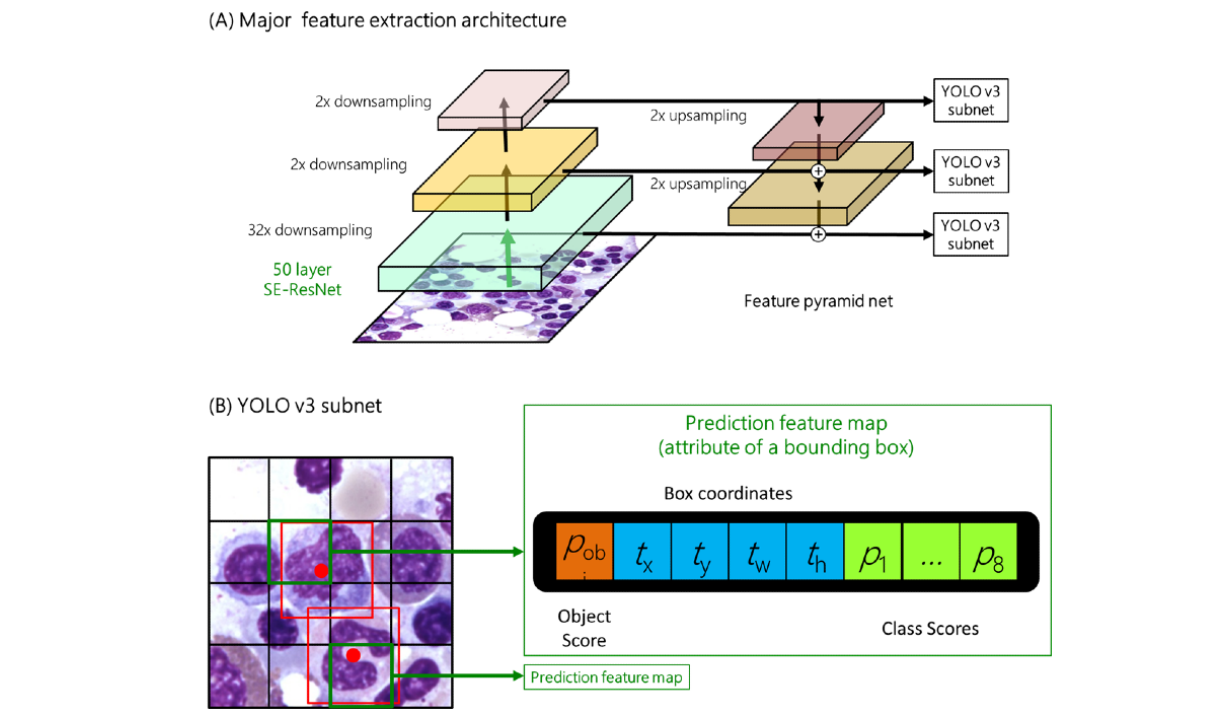
Figure 1. Deep learning model architecture. Our model contains a feature extraction architecture and a bounding box prediction subnet. The feature extraction architecture is based on a standard 50-layer SE-ResNet and a feature pyramid net, as illustrated in the upper half of the figure. The lower half illustrates the bounding box prediction process, which is based on the YOLO v3 architecture.